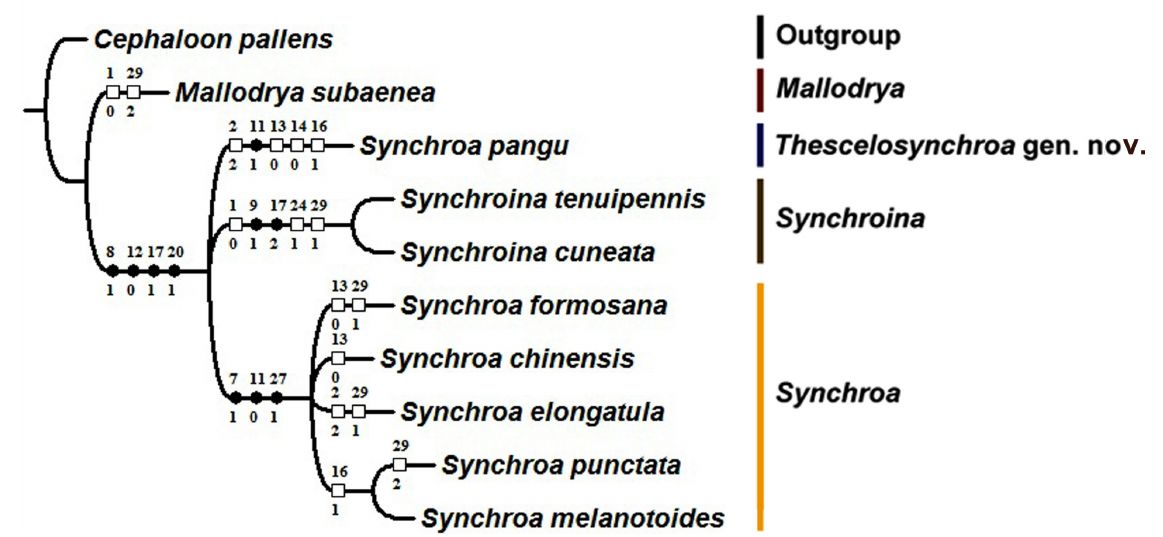
Fig. 10. Phylogenetic reconstruction of Synchroidae. Majority consensus tree with characters mapped on branches using unambiguous character changes in WinClada. Tree length = 54; Consistency Index = 81; Retention Index =